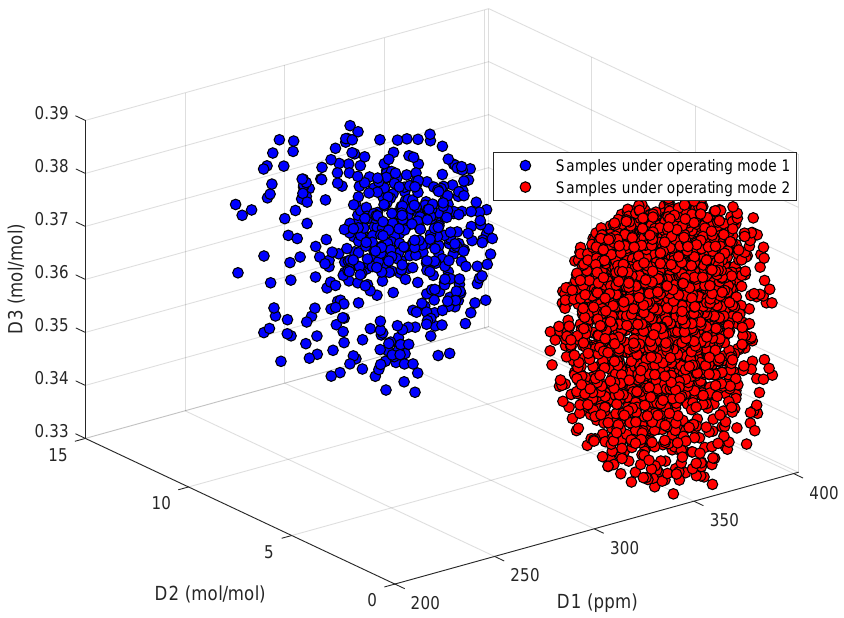
Figure 3. Samples with MF value above 0.8 under two operating